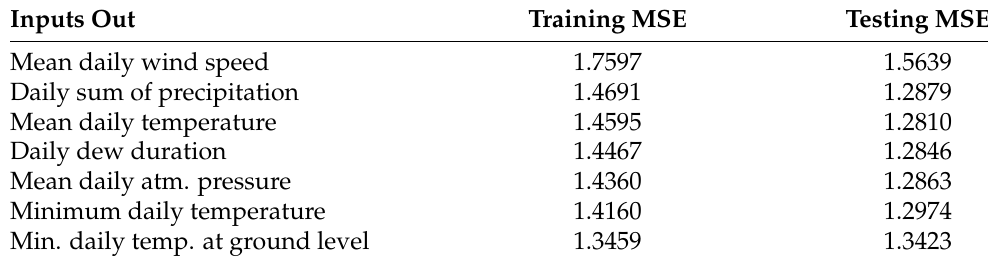
Table A14. The results of the sensitivity analysis for the prediction of the mean daily wind speed.